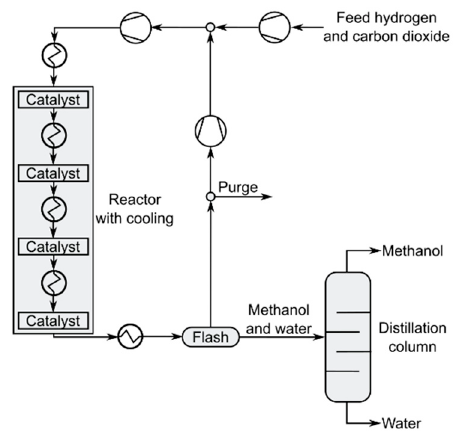
Figure 2. Generic CO 2 -based MeOH production process [37].